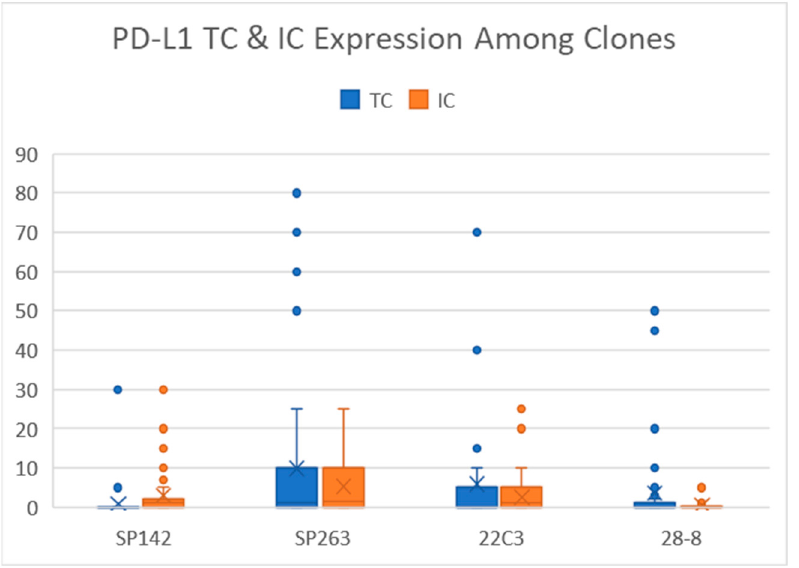
Figure 1. TC and IC scores of the four PD-L1 clones. Overall, SP263 had the highest expression of TCs and ICs. SP142 had negligible TC expression, and 28-8 had extremely low IC expression.